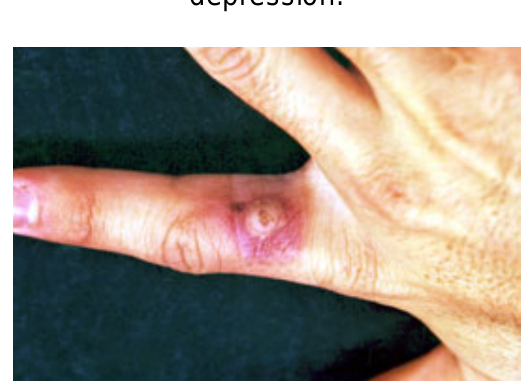
Figure 3: Umbilicated lesions surrounded by erythema.